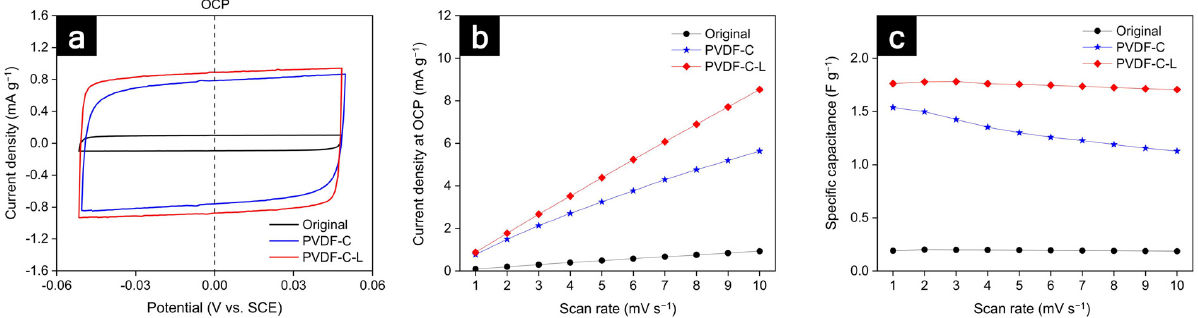
Figure 6. ( a ) CV curves at a scan rate of 1 mV S − 1 ; ( b ) the current densities in the OCP state versus the scan rate; ( c ) the variation of specific capacitance versus scan rate.